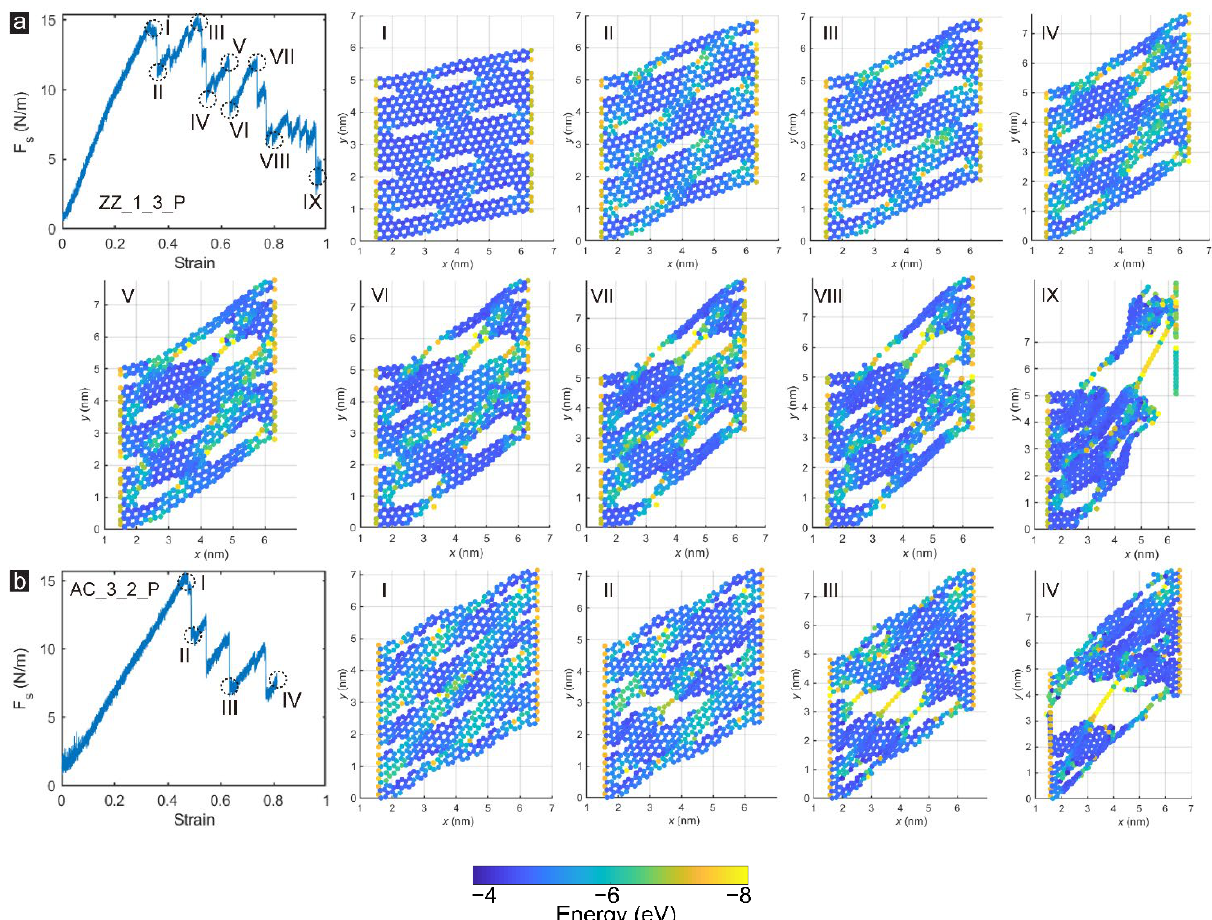
Figure 9. The snapshots of the microstructural damage processes and failure characteristics of the GK membrane: Sample ( a ) ZZ_1_3 and ( b ) AC_3_2 loaded perpendicular to the direction of the incisions.